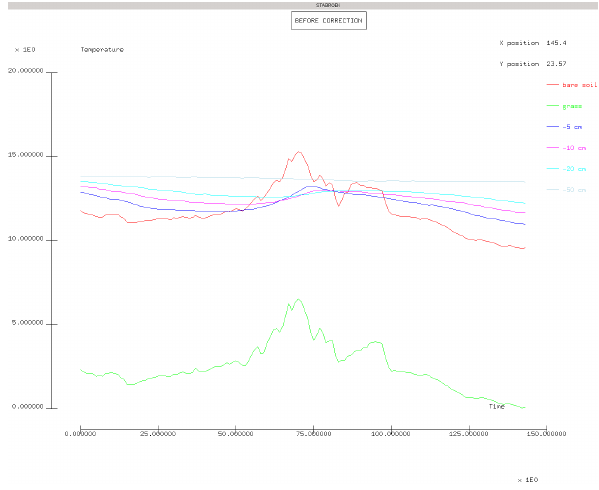
Figure 6. Visualization of the automated QC applied on the 10-min soil/grass temperatures records performed on 3 November 2014 at the Stabroek station (AWS 6438, see Table 1). No erroneous or sus- pect data were found in the daily 10-min temperatures time